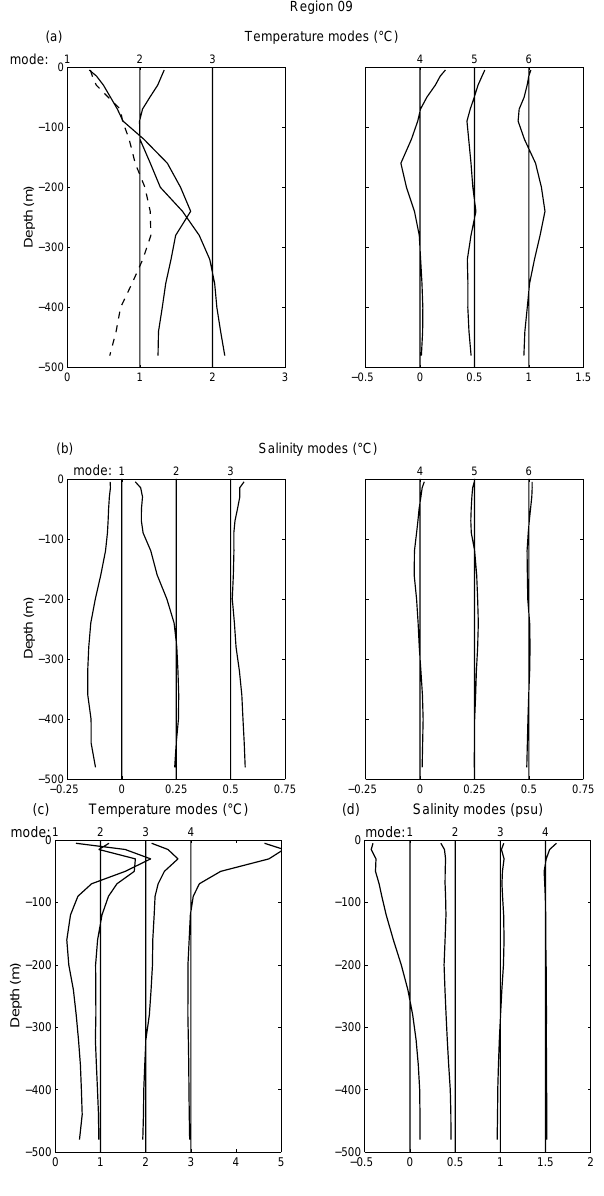
Fig. 8. Vertical EOFs for region 9 (Levantine Basin): (a) temper- ature and (b) salinity modes in winter, and (c) temperature and (d) salinity modes in summer. The first six winter modes and four sum- mer modes are shown. For graphical convenience, a dashed line is used to indicate a change in sign. For ease of presentation, offsets of 1 ◦ C and 0.5 ◦ C have been added to the first and the second triplets of T modes, respectively, and an offset of 0.25psu has been added to each S mode.